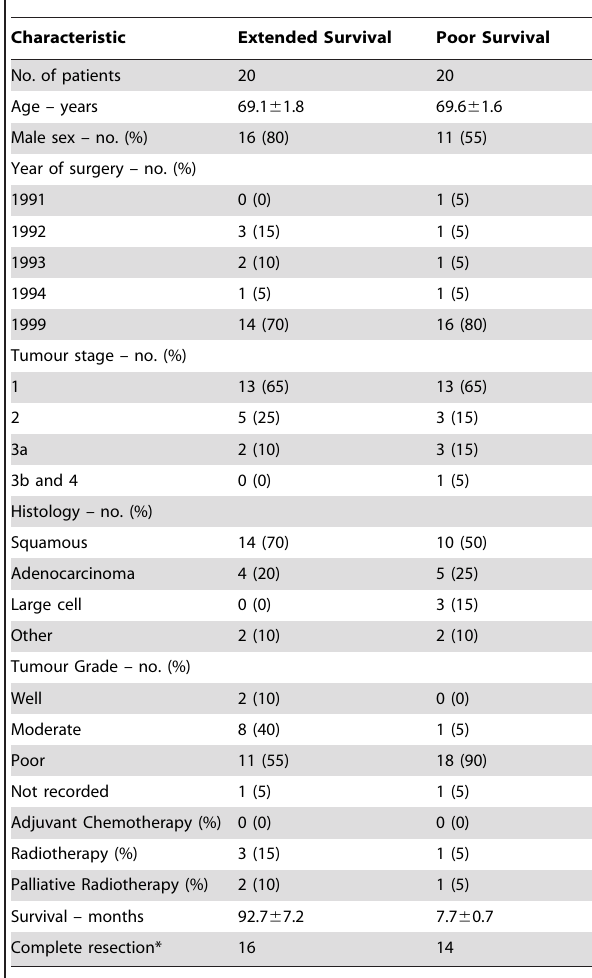
Table 1. Patient